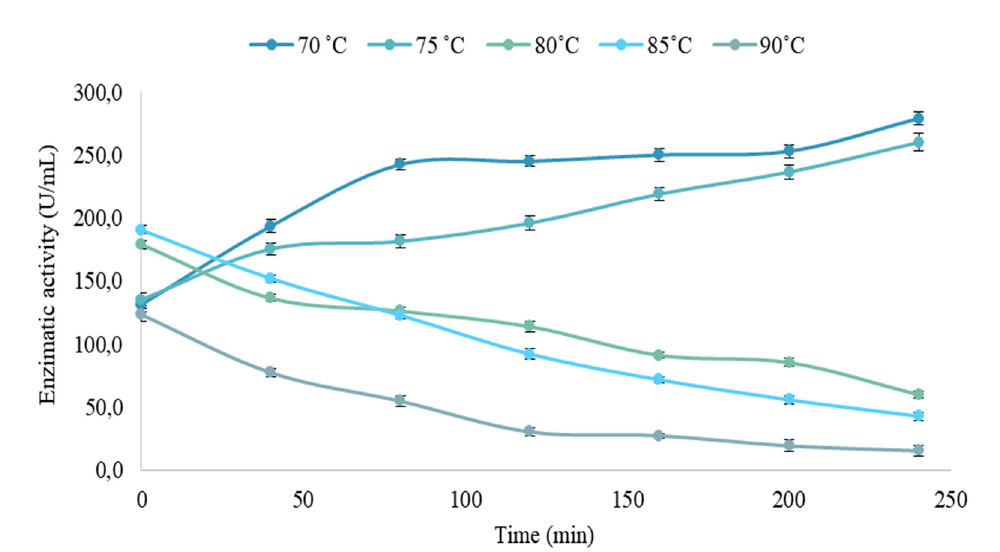
FIGURE 4B - Thermal stability in the production of β -CD at temperatures of 70 to 90 °C. Conditions: 10% (w/V) cassava starch and 0.02% (V/V)